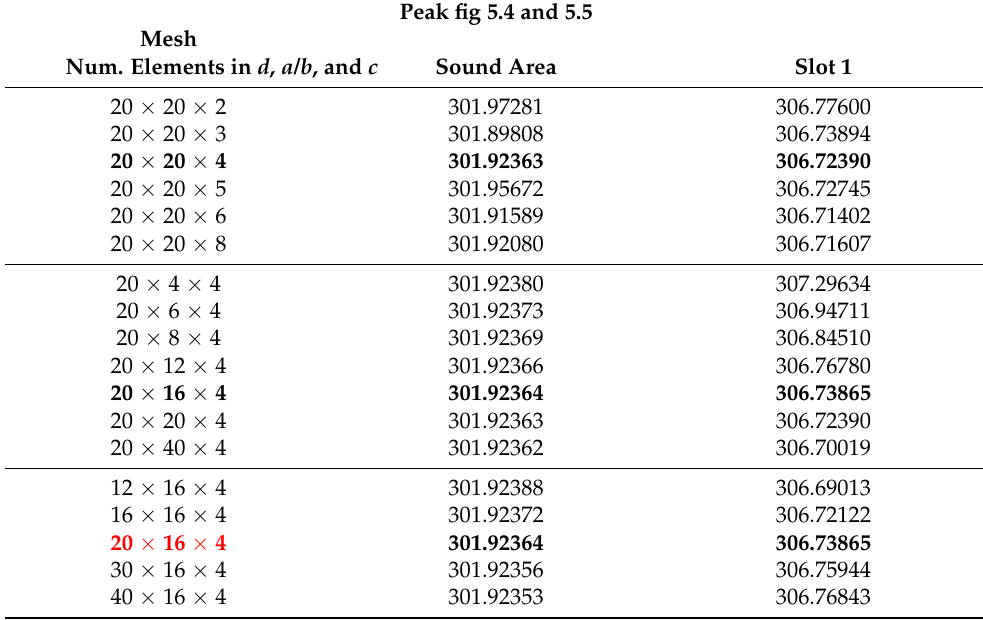
Table 1. Reference temperatures from the center of the sound area and slot 1, obtained with various